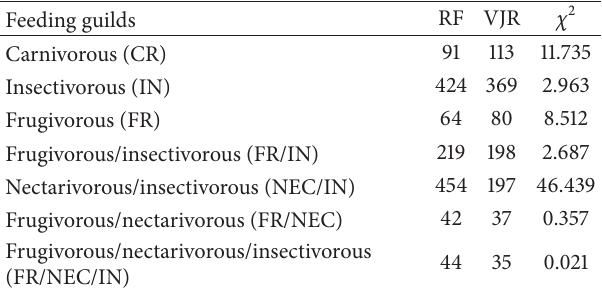
Table 3: Feeding guild distribution of understorey bird communi- ties in ( 𝑃 < 0.05 ) RF and